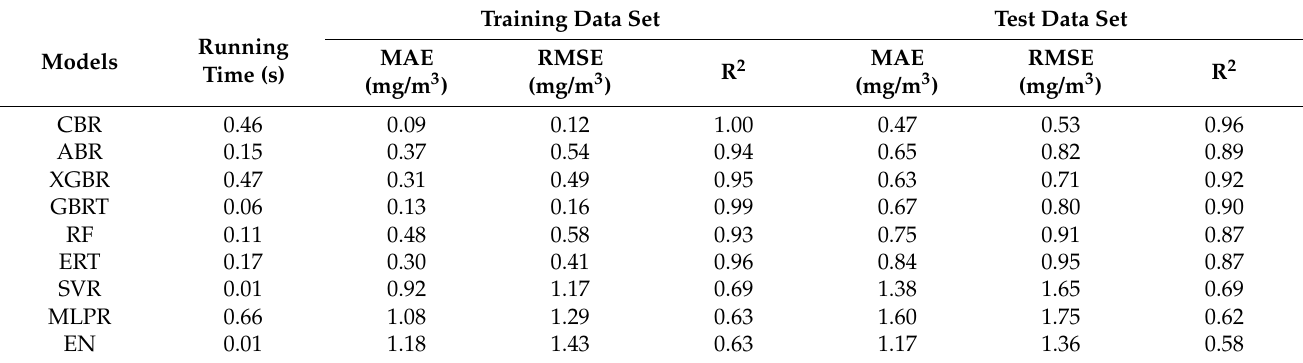
Table 4. Experimental results of Chl-a (mg/m 3 ) using different